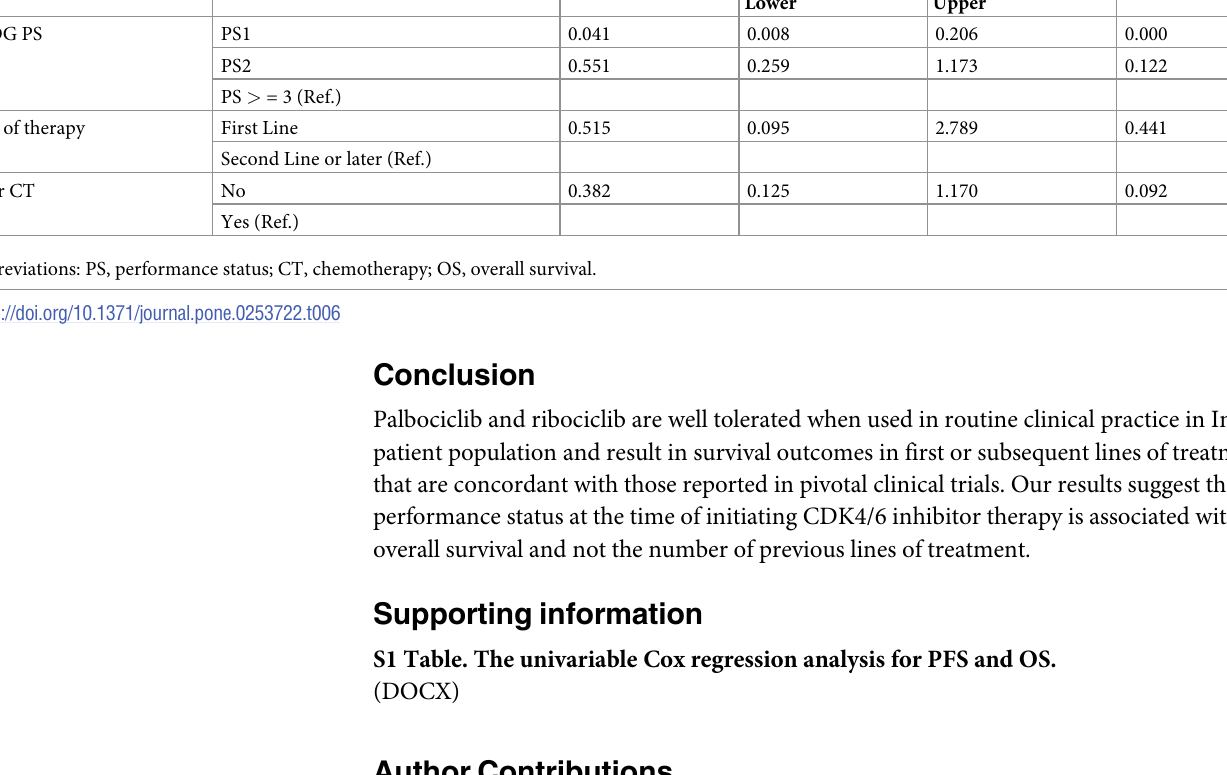
S1 Table. The univariable Cox regression analysis for PFS and OS.